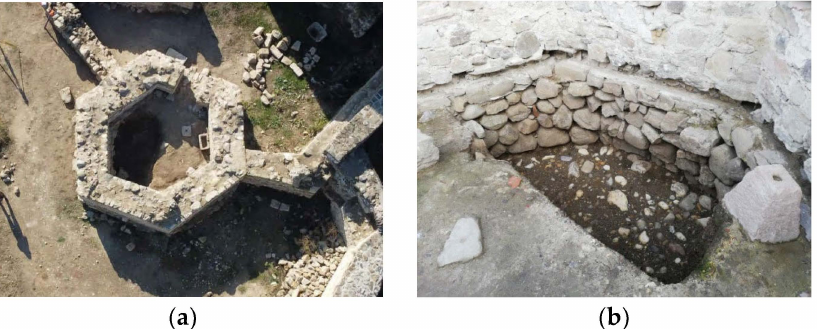
Figure 23. Archeological site of Tower Dzephana. ( a ) Aerial view. ( b ) Detail of the foundation (Photo source: private archive of Vladan Vidosavljevi´c).